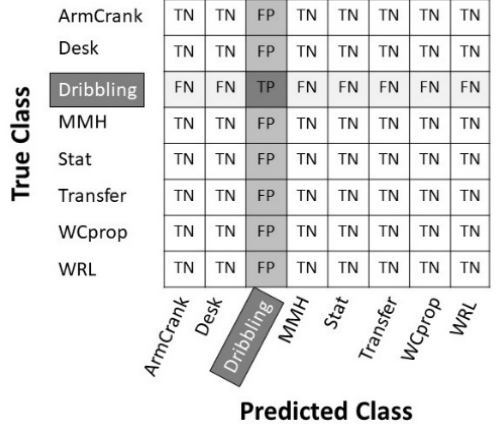
Figure 3. The multiclass confusion chart for class “Dribbling”.